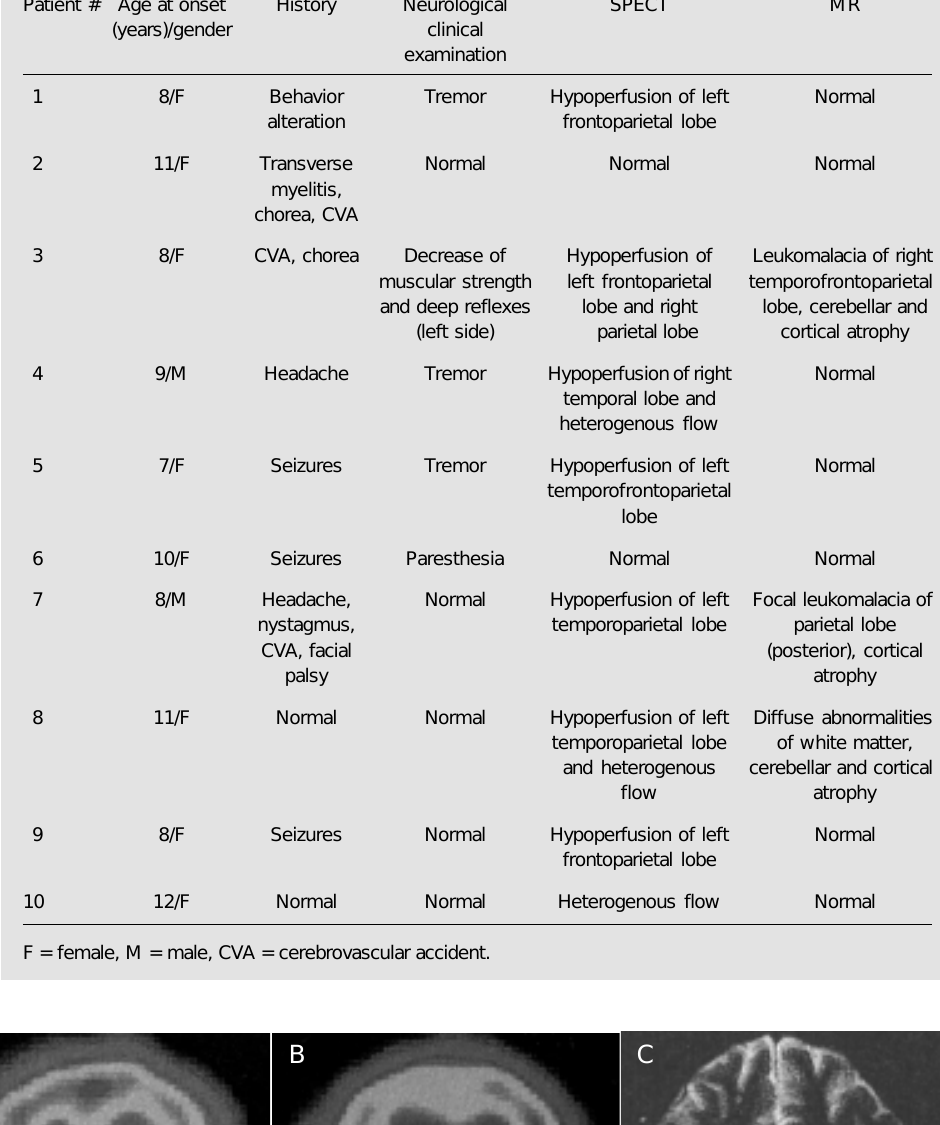
Figure 1. Most common changes observed in the SPECT: cerebral hypo- perfusion (A) and hetero- geneous distribution of blood flow (B). The most common MR abnormali- ties were leukomalacia (C) and diffuse alter- ations of white